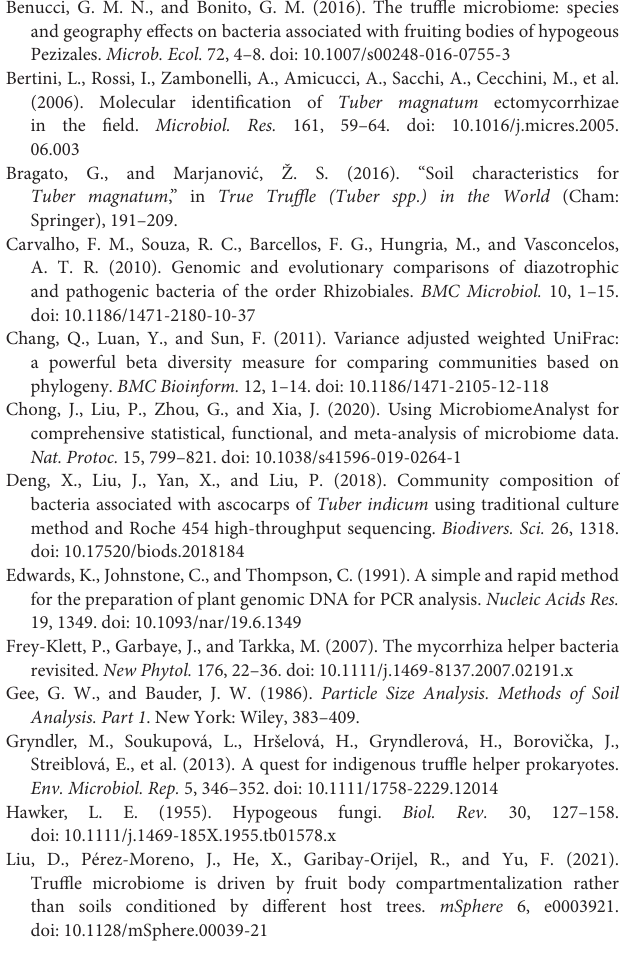
log-transformed count) of the taxa in the four tested conditions. Supplementary Table S1 | List of identified OTUs at different taxonomical levels. Supplementary Table S2 | Statistical results related to physical and chemical soil